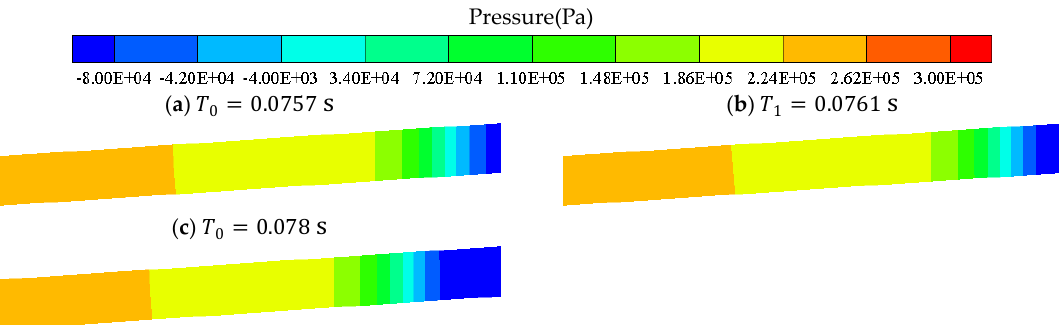
Figure 32. Velocity field evolution on the axis plane of the pipeline in the cavity growth stage.